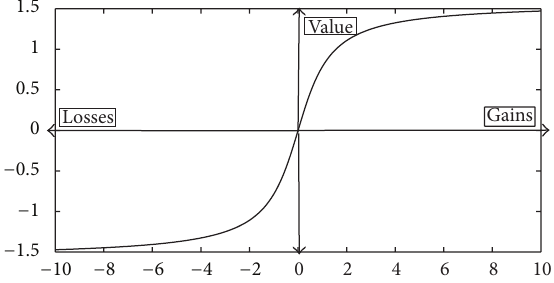
Figure 3: TODIM value